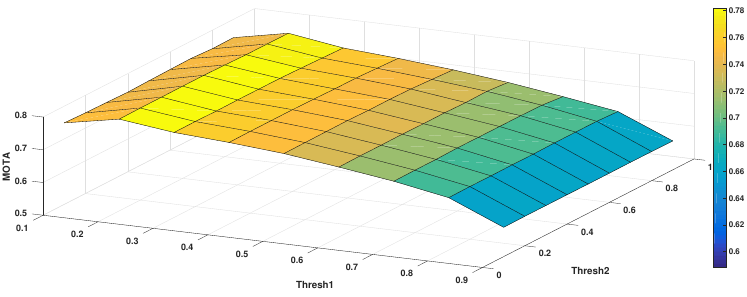
Figure 5. The MOTA value in relation to τ 1 and τ 2 on the training